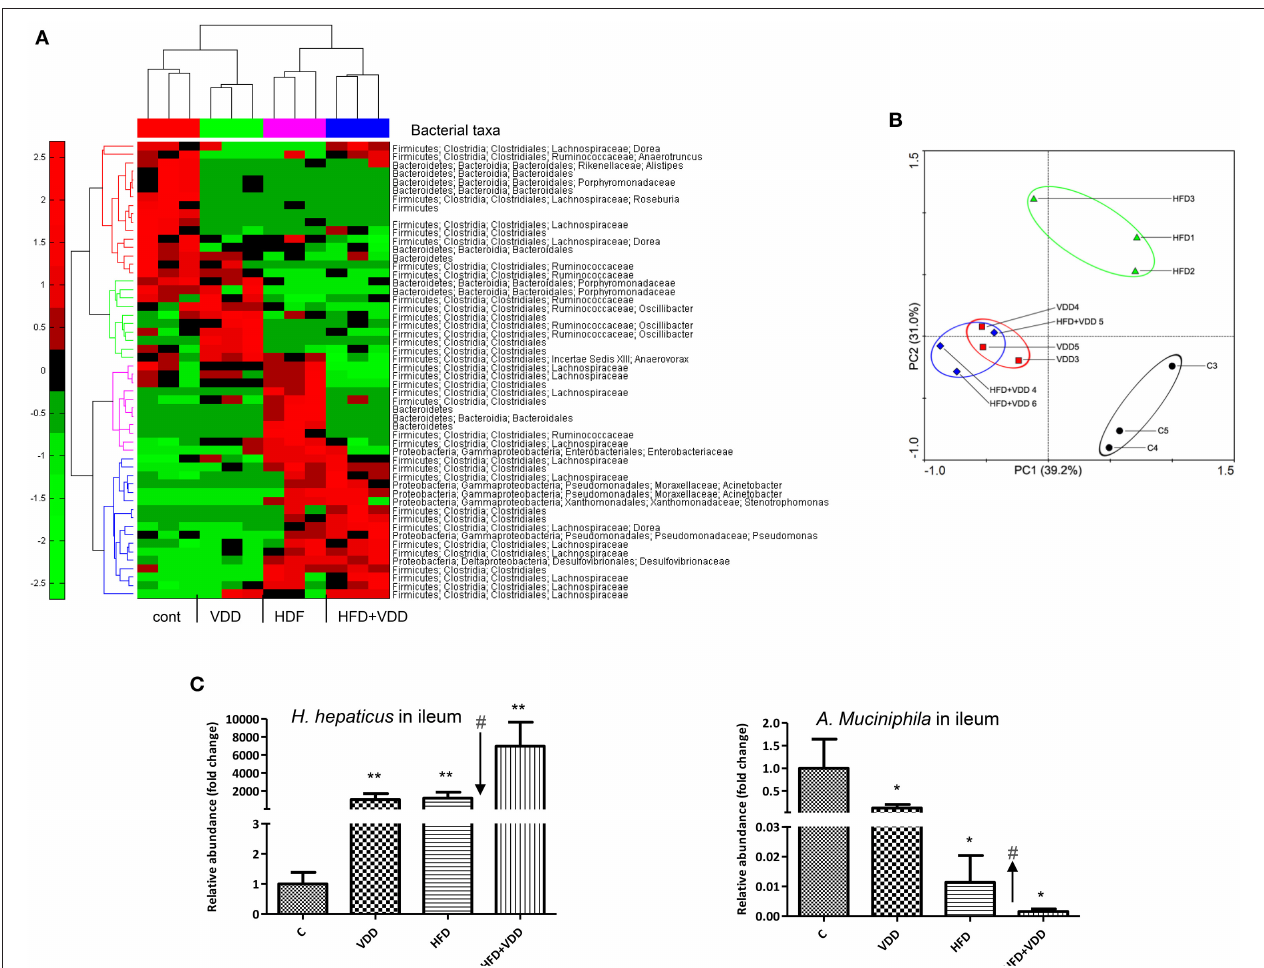
FIGURE 5 | Initial dysbiosis in the ileum induced by high fat feeding is exacerbated by additional vitamin D deficiency. (A) The microbiota in the ileal lumen of the mice by the four feeding conditions were determined by 16S ribosomal (rRNA) gene sequencing analysis ( n = 6), and presented as hierarchical heat-map with bacterial taxa ( n = 3). (B) Principle component analysis (PCA). (C) The relative abundances of Helicobacter hepaticus and Akkermansia muciniphila were determined by qPCR analysis by species-specific primers. Data represent two independent experiments ( n = 6 for each measurement). Error bars represent the SEM of samples within a group. * p ≤ 0.05, ** p ≤ 0.01 (Student’s t -test). The arrows indicate the impact of vitamin D supplement to ameliorate the dysbiosis. # indicates the impact of vitamin